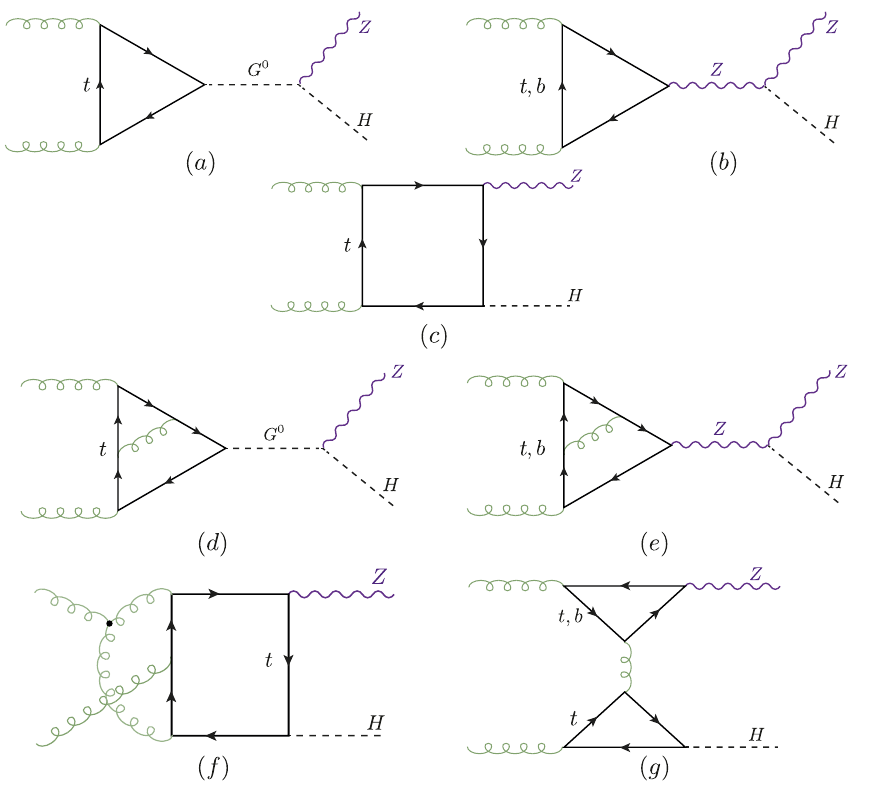
Figure 1 . Examples of Feynman diagrams contributing to gg → ZH at LO and